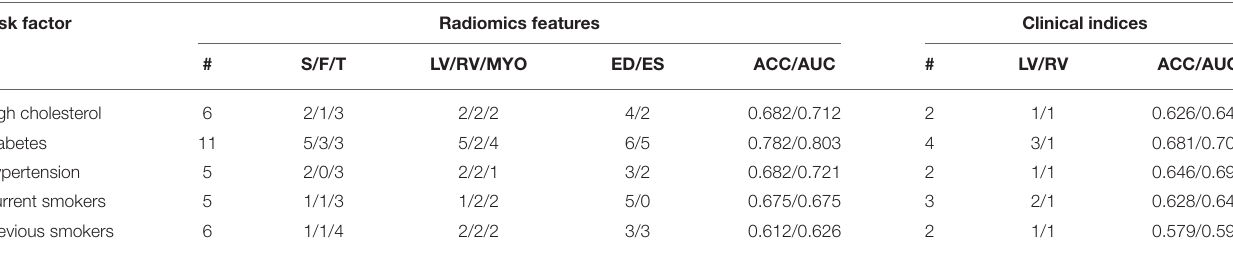
TABLE 4 | Selected number of radiomic features used for each risk factor and their discriminative accuracy, and results obtained based on conventional imaging indices and size information. Risk